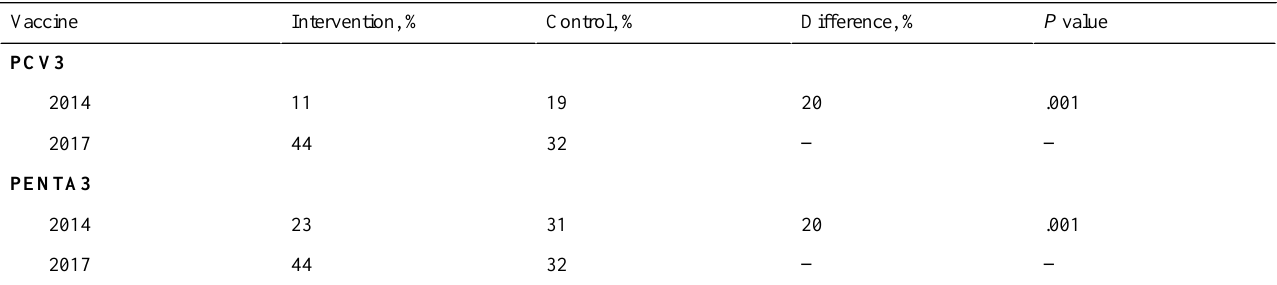
Table 1. Improvement in the vaccine coverage rate from 2014 to 2017 during the Health Systems Strengthening (HSS) immunization pilot study [19].